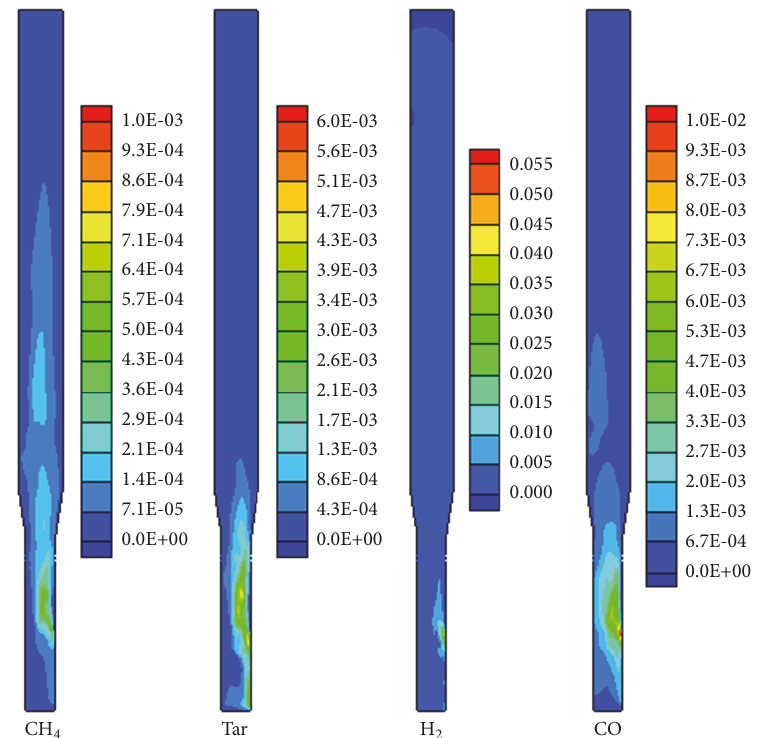
Figure 10: Time-averaged homogeneous reaction rates (CH 4 , CO, tar, and H 2 ) (kmol/m 3 ⋅